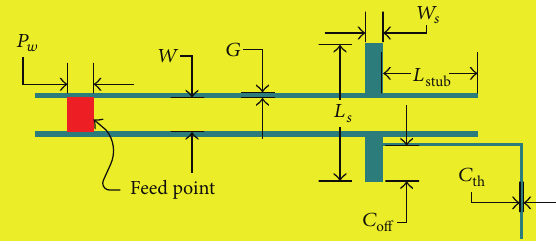
Figure 4: Top view of proposed antenna geometry ( XY plane), with 𝑊 = 0.19 mm, 𝐺 = 20 𝜇 m, 𝐿 0.5 mm, 𝐶 off = 0.15 mm, and 𝑃 𝑤 =